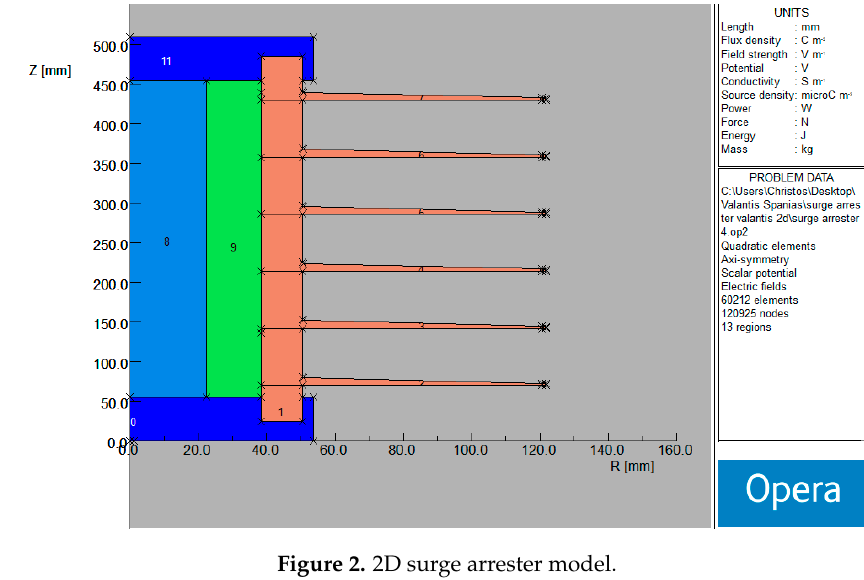
Figure 2. 2D surge arrester model. Energies 2018 , 11 , x FOR PEER REVIEW